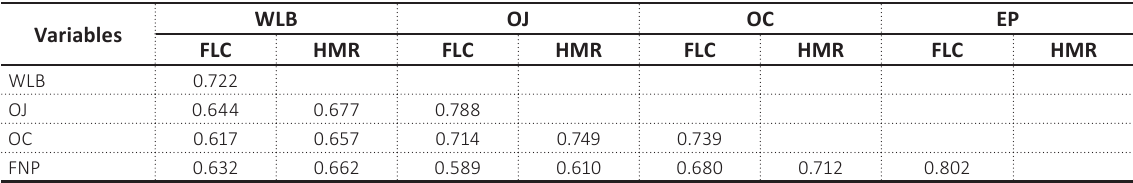
Source: The result of data processing from SmartPLS.